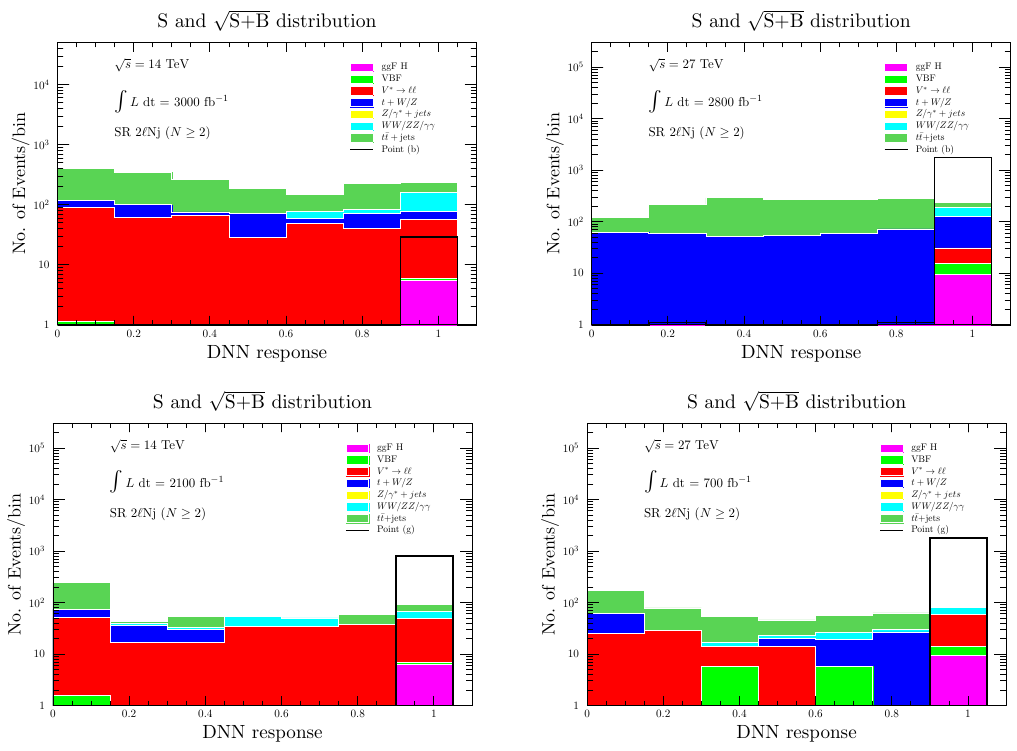
Figure 5 . Distributions in the DNN response variable at 14 TeV (left) and 27 TeV (right) for benchmarks (b) (top panels) and (g) (bottom